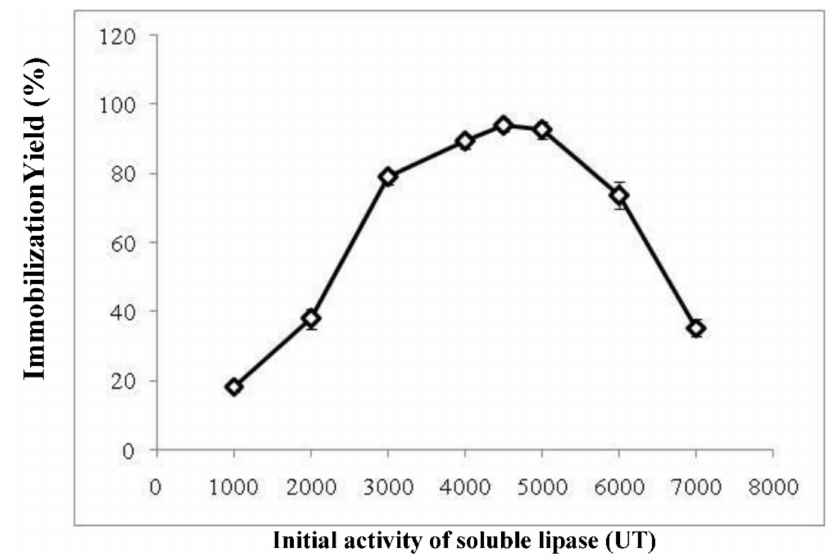
Figure 1. Yields of immobilized B. stearothermophilus lipase determined using different initial lipase amounts. Enzyme activity was measured using an olive oil emulsion at pH 12 and 60 ◦ C. Data are expressed as the mean ± standard deviation of triplicate